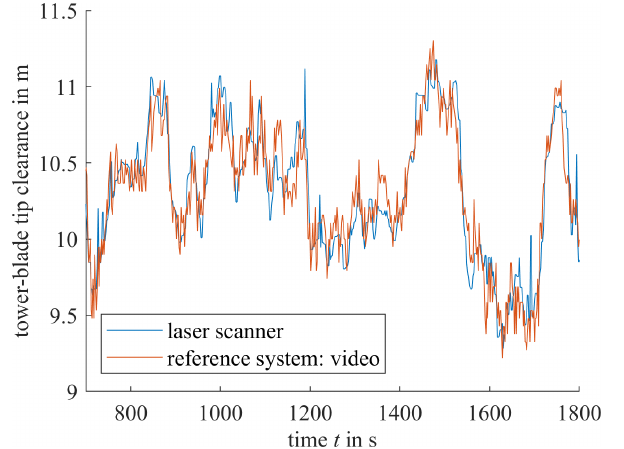
Figure 14. Tower–blade tip clearance over time with a laser scanner and video reference measurement system. Note that the graph con- sists of discrete points with a time interval of 1–2s. However, they are shown here as continuous in order to improve visualization.